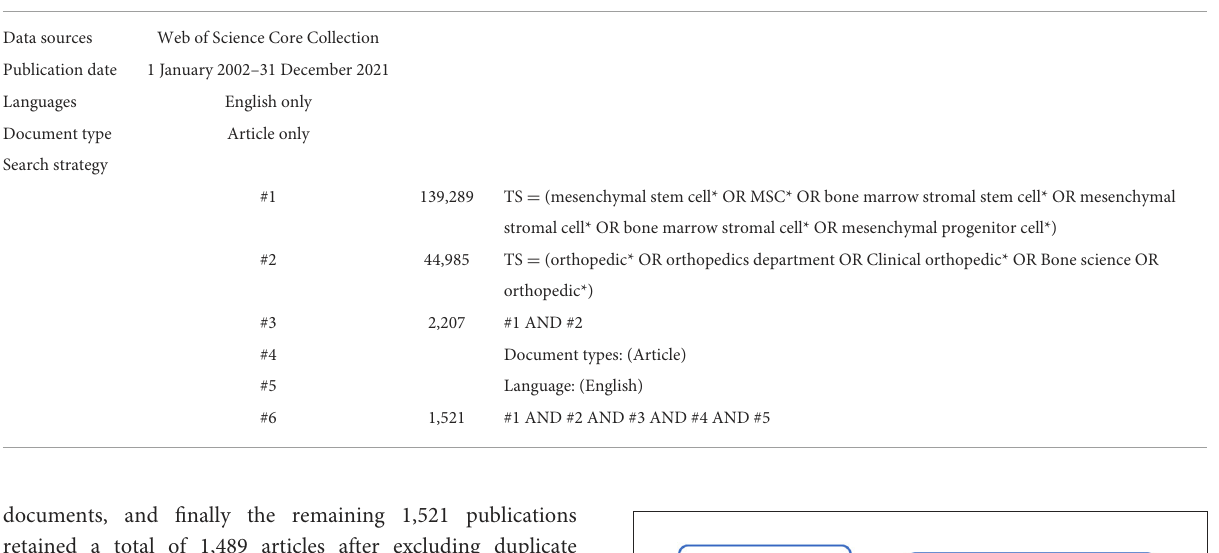
TABLE 1 Data sources and flow of retrieval strategy.